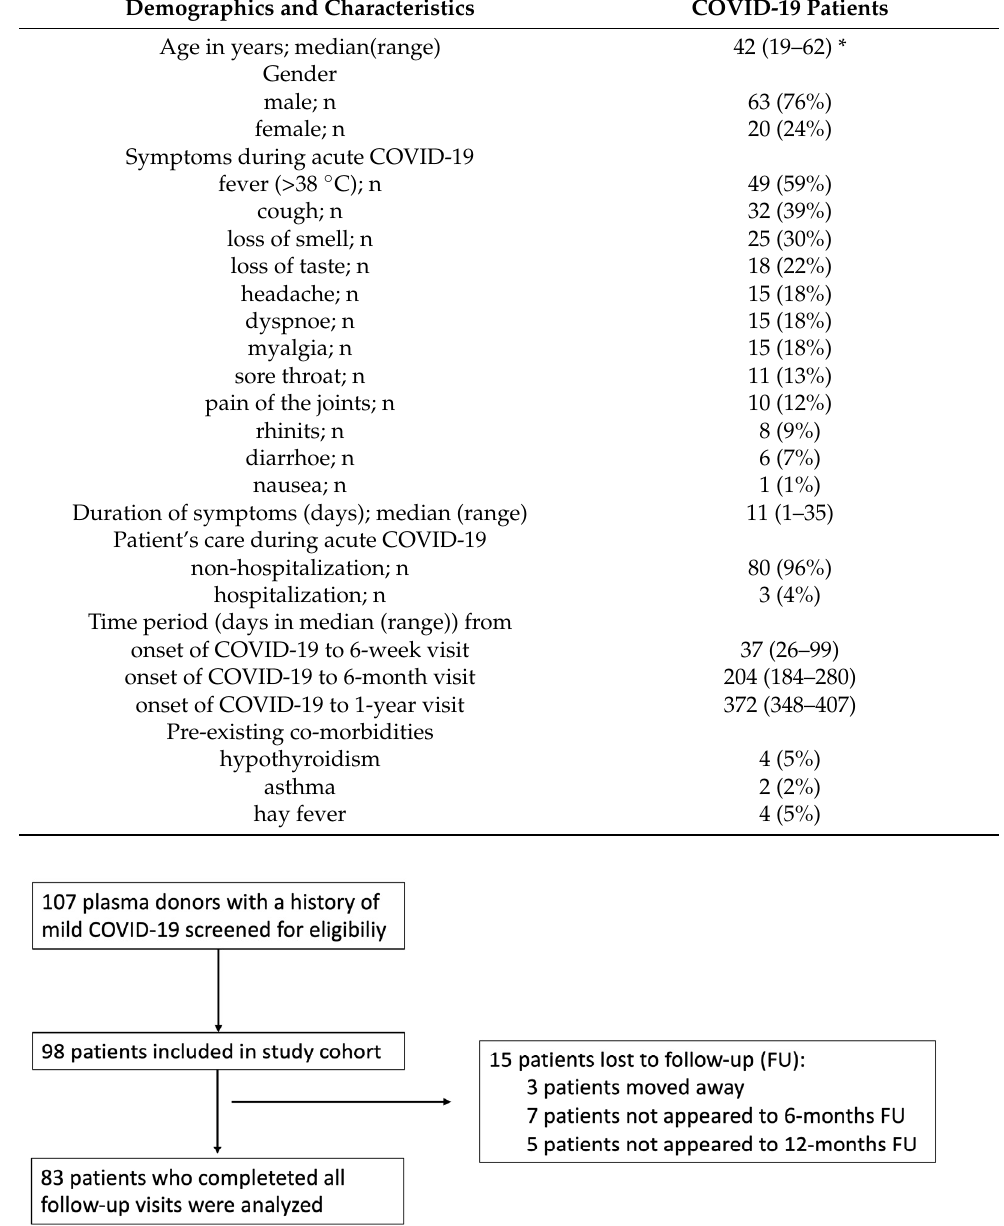
Figure 2. Consort diagram for this prospective study. Table 1. Demographics and characteristics of 83 evaluable patients during acute COVID-19. * Homogeneous distribution across the years.